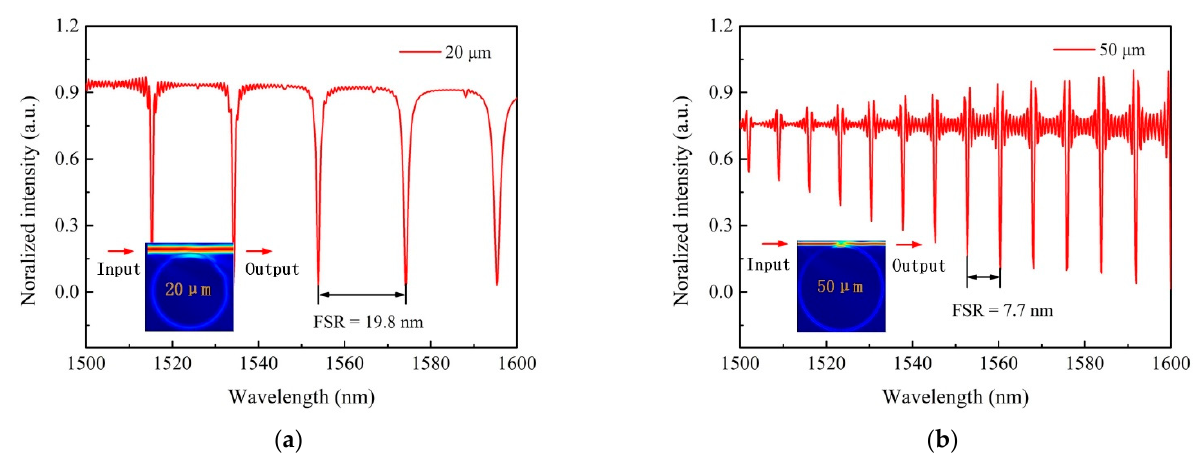
Figure 4. Calculated transmission spectra of different WGM resonators for microspheres with a diameter of ( a ) 20 μ m and ( b ) 50 μ m.